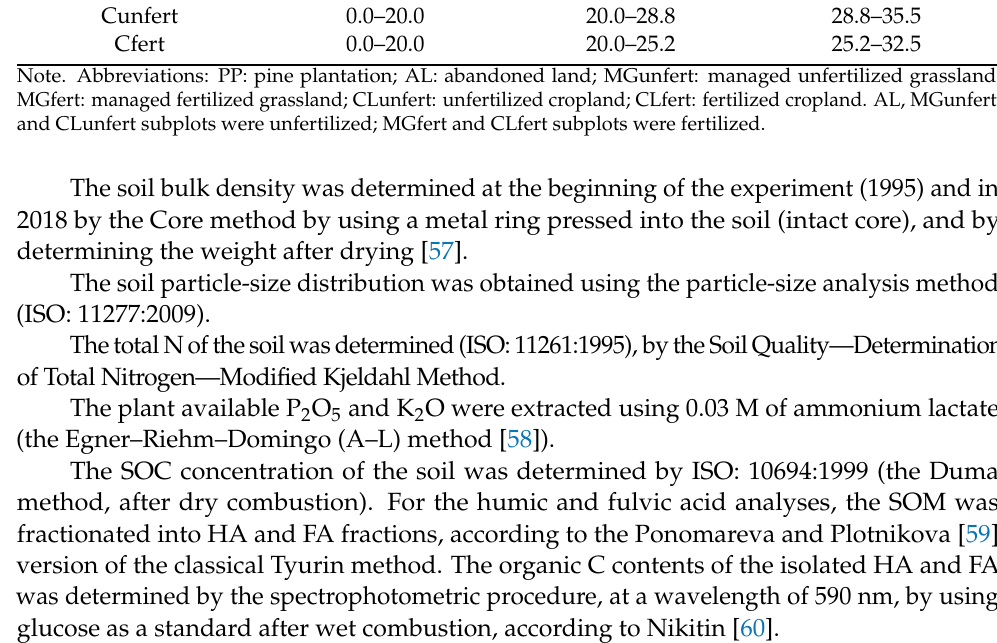
Table 3. Soil sampling over A and AB horizons of Arenosol in different land-use sites. Soil Sampling over Depths (cm) Under Land Use A Horizon: Layer 1 A Horizon: Layer 2 AB Horizon PP